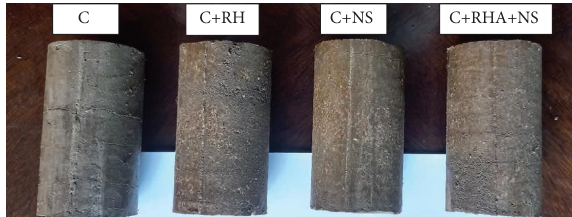
Figure 2: Te UCT test samples of clay and its mixes.